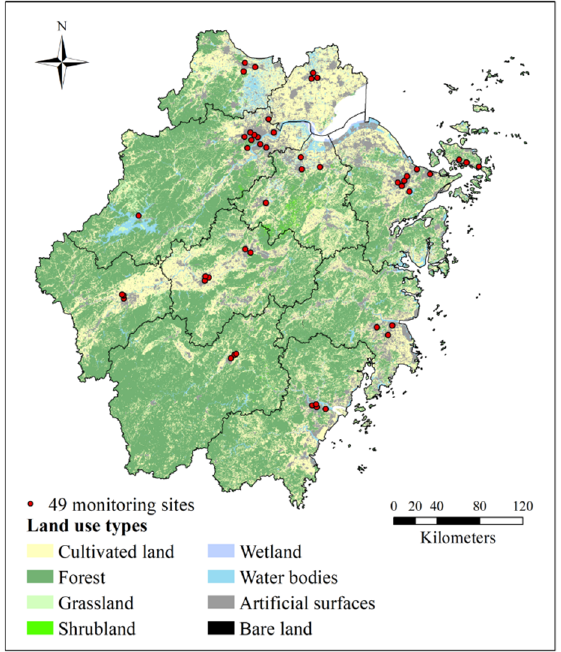
Figure 1. Location of the study area and spatial distribution of monitoring sites and land use types. The PM 2.5 concentration data used hourly monitoring data of pollutants in µ g/m 3 from 1 January 2020 to 31 December 2020 at state-controlled air quality monitoring sta- tions. Data were obtained from the China National Environmental Monitoring Centre (http://www.cnemc.cn/, accessed on 20 June 2022). This study was mainly based on the annual average PM 2.5 concentration. For the validity of the data, PM 2.5 concentration data were pre-processed. Firstly, anomalous values with concentration values less than zero or meaningless were excluded. Secondly, according to the China Ambient Air Quality Standards (GB 3095-2012) on data validity, there should be at least 20 h of average concen- tration or sampling time per day. When calculating the annual average concentrations, there should be at least 324 daily average concentration values per year and at least 27 daily average concentration values per month (at least 25 daily average concentration values in February). According to the above principles, invalid data were eliminated and 49 valid annual average data sites were retained in total.